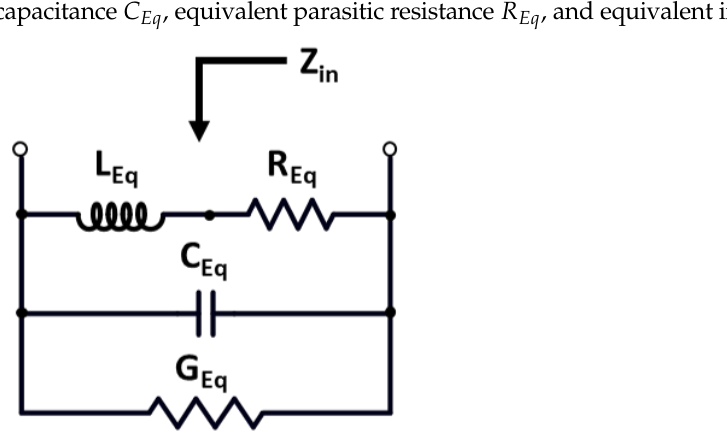
Figure 5. Equivalent circuit diagram of the proposed